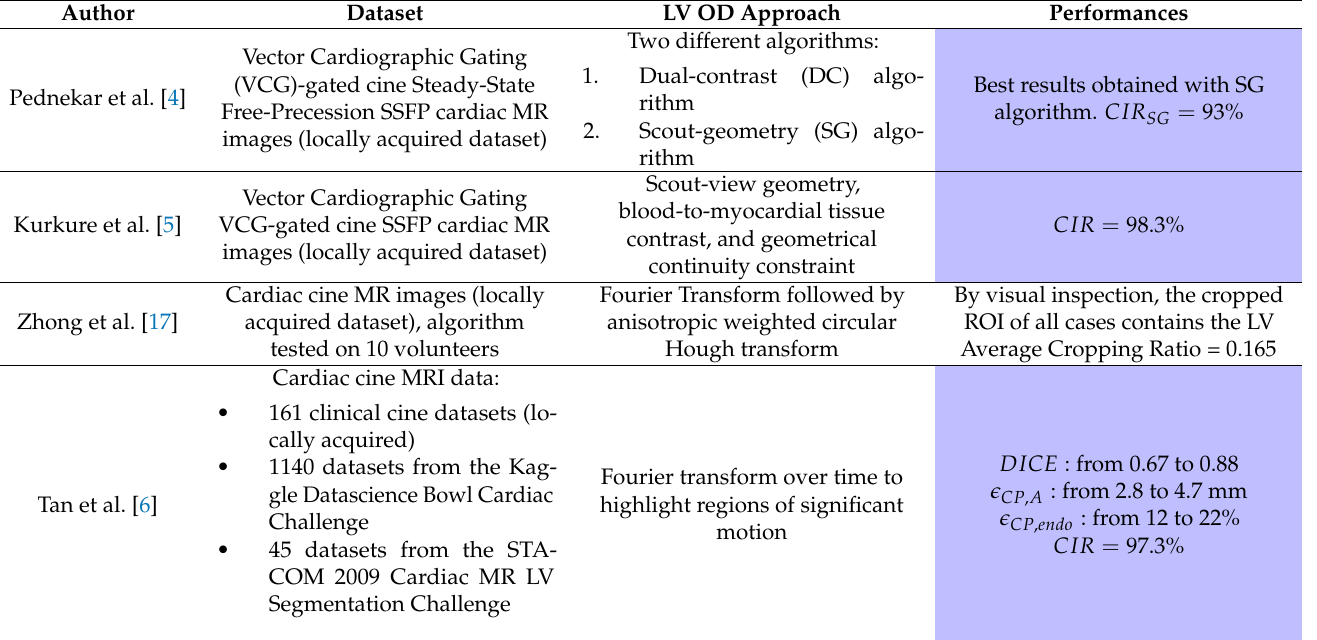
Table 3. Performances of LV localization tasks in relevant works in literature. Performances compara- ble with ours are